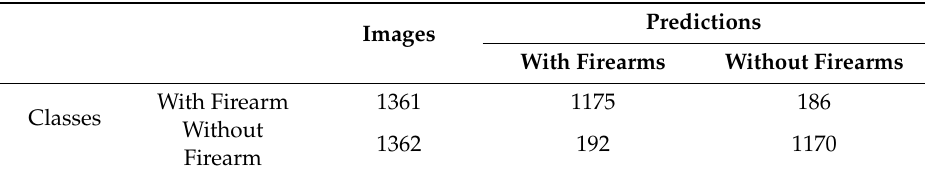
Table 6. Confusion matrix.